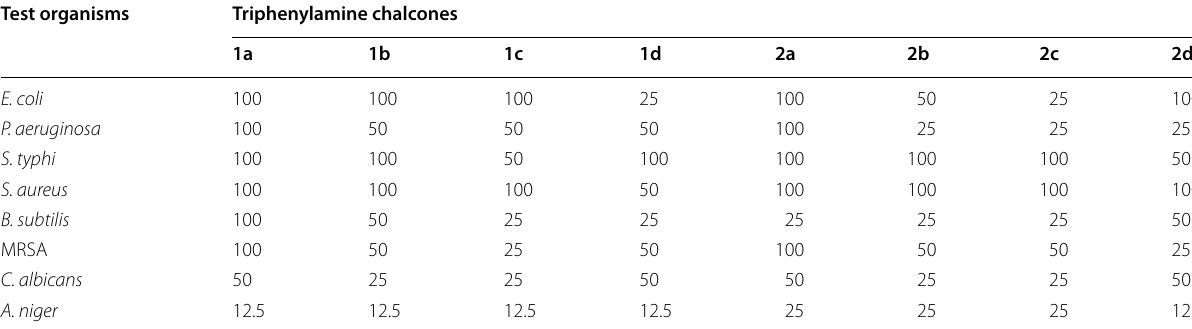
Table 3 Minimum inhibitory concentrations (MIC) of the synthesized compounds (µg/ml) Test